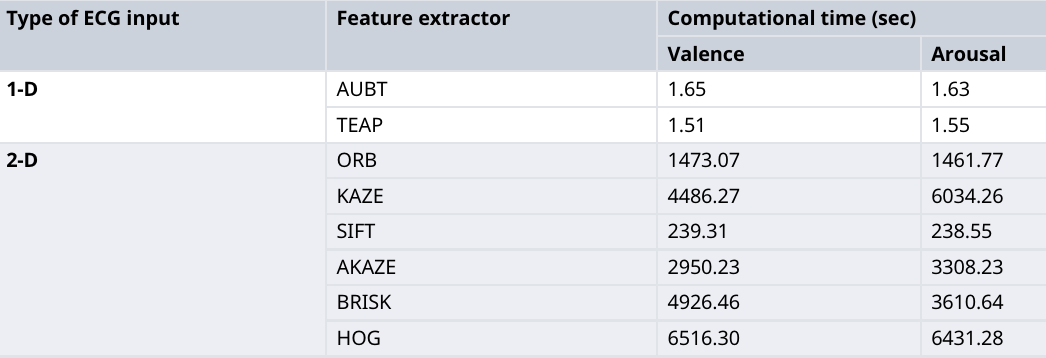
Table 7. Computation Time for Each Feature Extractor using Support Vector Machine